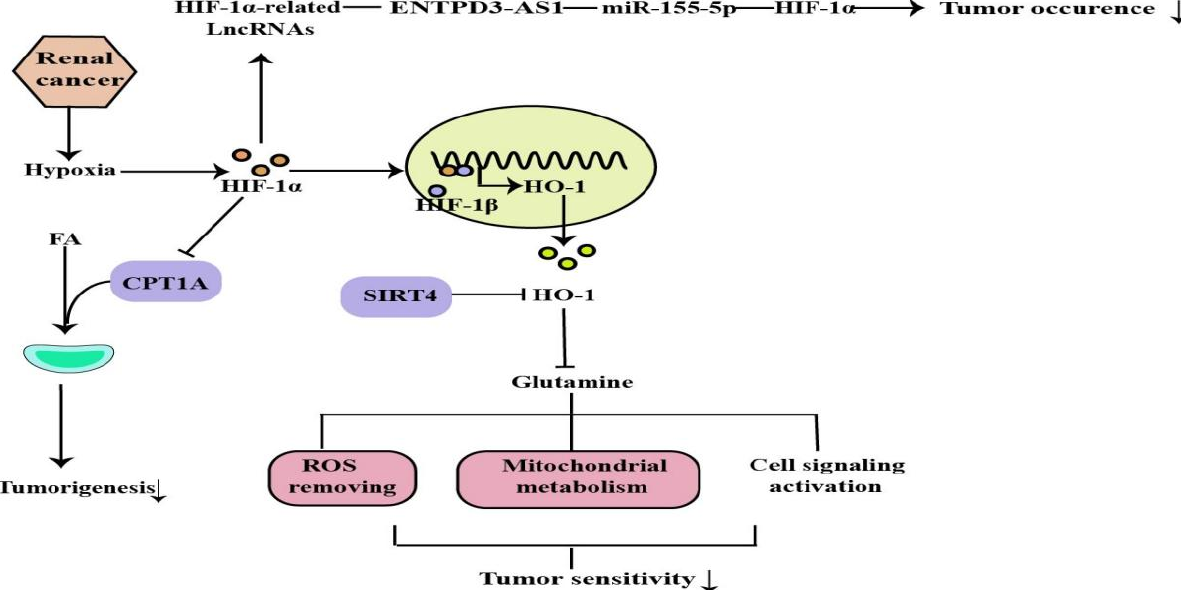
Figure 5. ROS removing , mitochondrial metabolism, cell signaling activation are regulated by HIF- 1 α , which can regulate tumor occurrence and sensitivity through the above mechanisms ( ↓ : de- creased